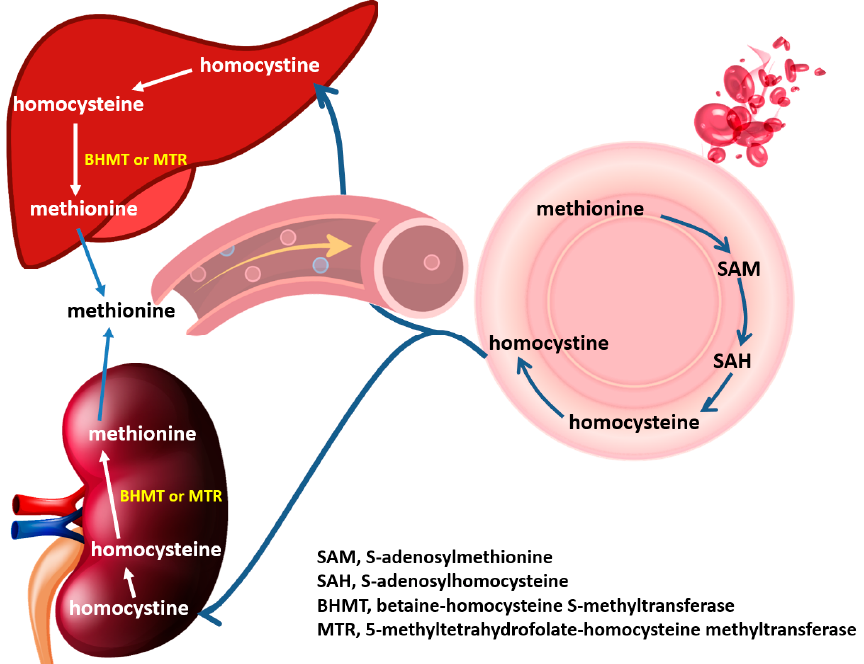
Figure 7. Diagram of erythrocytic-renal cycle and erythrocytic-hepatic cycle. In erythrocytes, methionine is converted to SAM, which is a methyl donor for numerous reactions. After losing its methyl group, SAM becomes SAH, which is then converted to homocysteine. Homocysteine exerts its antioxidative effect and converts to homocystine and then releases to extracellular fluid and transport in circulation to the kidney or liver, which shows enriched expression of BHMT and MTR. In the kidney or liver, homocysteine can be converted back to methionine by the addition of a methyl group. Finally, methionine is synthesized and returned to circulation for further utilization.